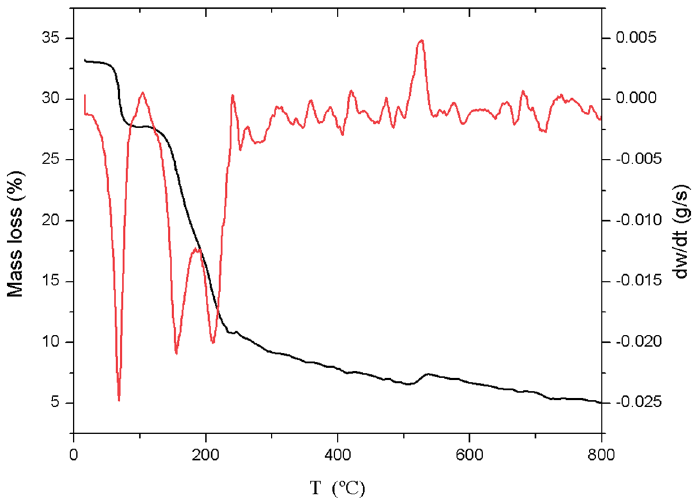
Figure 1. TG (black line) and DTG (red line) curves obtained from the carbonisation of OS. Cellulose polymers degraded between 150 and 200 °C [24], and in this case showed a maximum degradation rate at 165 °C, as observed in the peak of the DTG curve. This loss was 24% of the total weight of the sample.